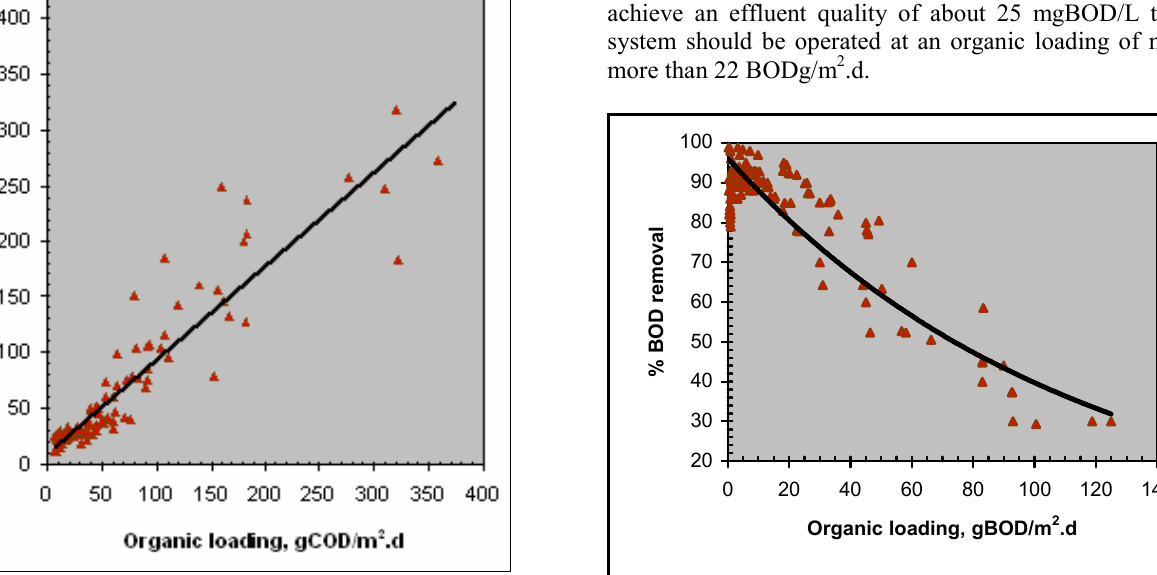
Figure 13: Effect of organic loading on the BOD removal efficiency (organic loading up to 140g BOD/m 2